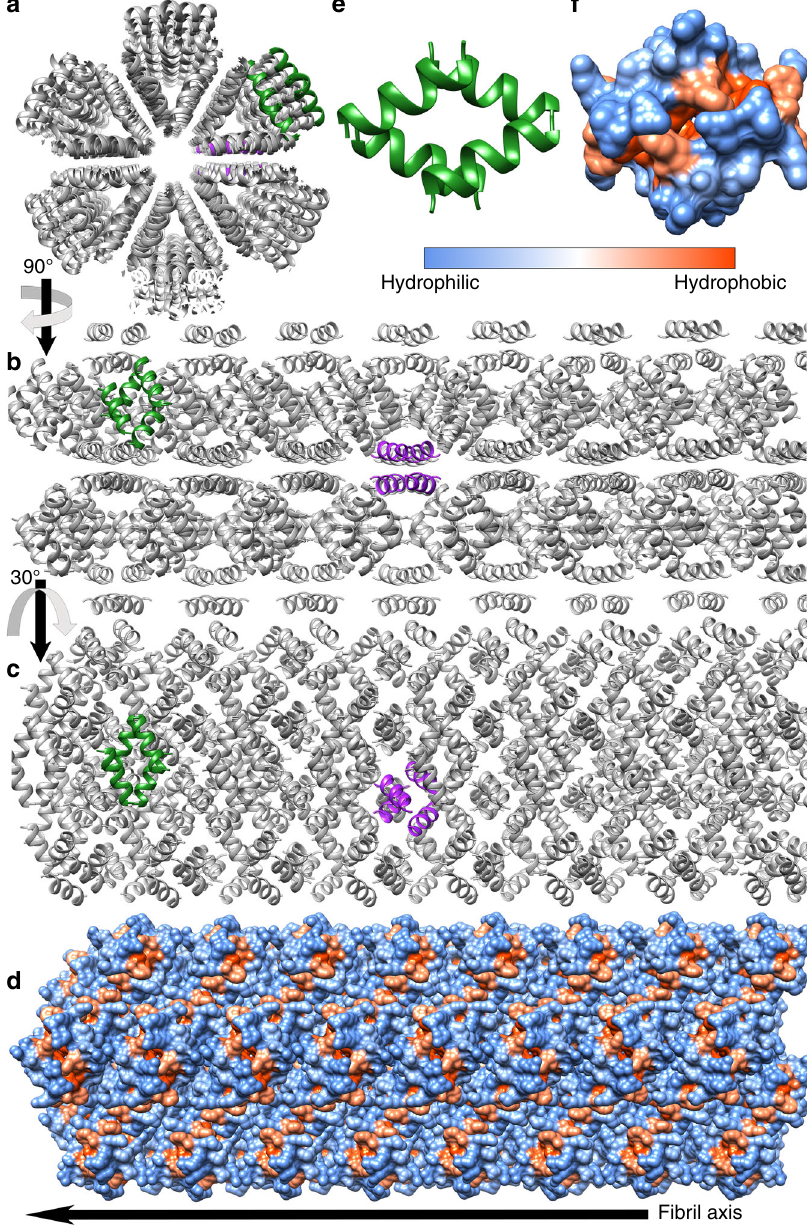
Fig. 3 The crystal structure of hLL-37 17-29 . The crystal structure of hLL-37 17-29 was determined at 1.35 Å resolution. The crystal packing shows self- assembly of amphipathic helices into a densely packed, elongated hexameric fi bril with a central pore. The fi bril is composed of four-helix bundles with a hydrophobic core that associated via a network of polar interaction (Fig. 5). a The assembly is shown as grey ribbons, with two representative four-helix bundles colored green and purple to emphasize orientation in the fi bril. b The view is rotated by 90 ˚ in relation to panel a, showing the structure along the fi bril axis. c The view is rotated by 30 ˚ along the fi bril axis compared to b . d The fi bril, in the same orientation as in panel c, is shown in a surface representation, colored by hydrophobicity, according to the scale bar. e An isolated four-helix bundle shown as green ribbons. f The four-helix bundle, in the same orientation as in e , shown in a surface representation colored by hydrophobicity, according to the scale